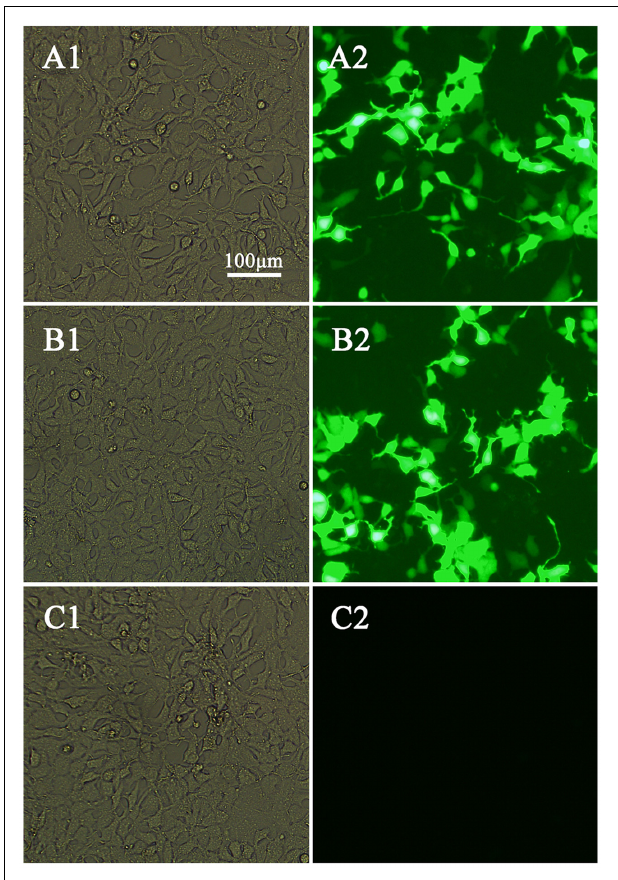
FIGURE 2 | Direct immunofluorescence detection of the fusion protein in transfected HEK 293-T cells. (A1) Cells transfected with pEGFP-C1 detected under white light; (A2) cells transfected with pEGFP-C1 detected under blue light; (B1) cells transfected with pEGFP-C1-SAG4 detected under white light; (B2) cells transfected with pEGFP-C1-SAG4 detected under blue light; (C1) untransfected cells under white light; and (C2) untransfected cells under blue light.